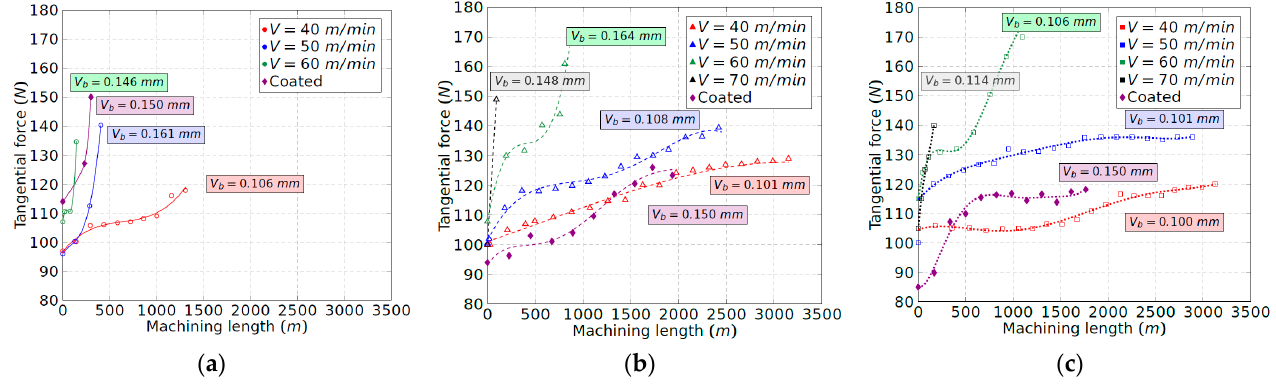
Figure 8. Tangential force evolution vs. machining length: ( a ) tool configuration 1; ( b ) tool configuration 2; and ( c ) tool configuration 3.